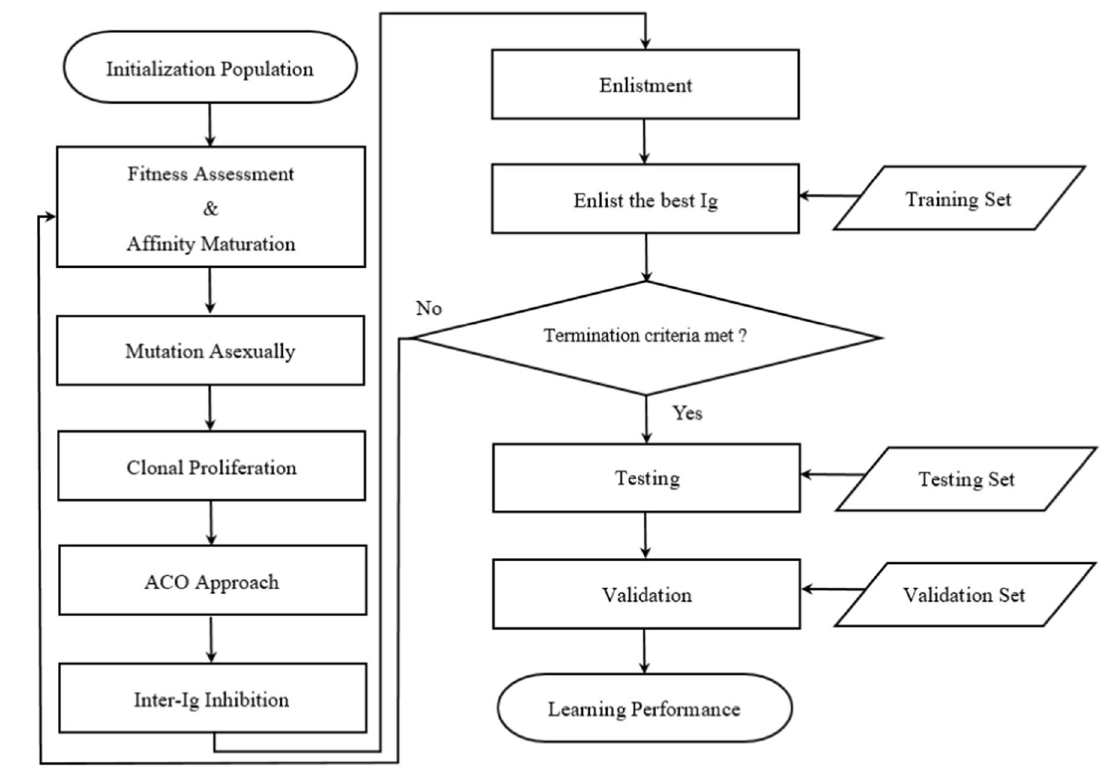
Fig. 1 The DFD for the proposed HIAO